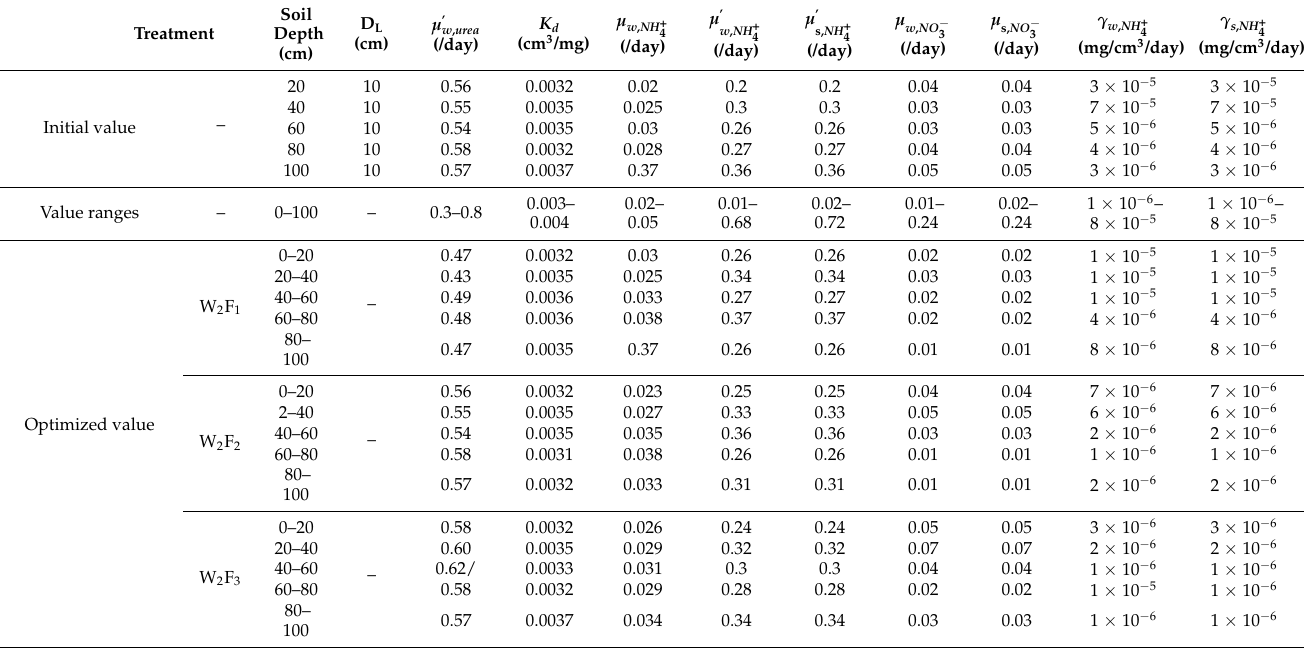
Table 5. Parameters of the V-G model with fertilizer (NH 4 NO 3 ) infiltration.